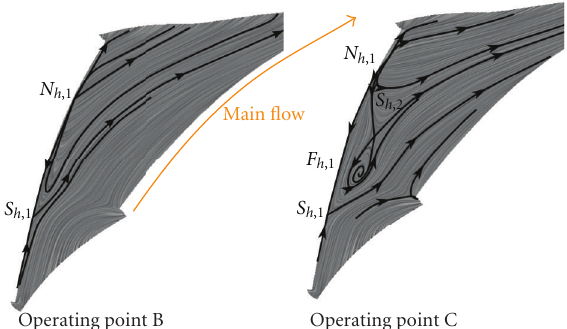
Figure 7: Hub skin-friction pattern.